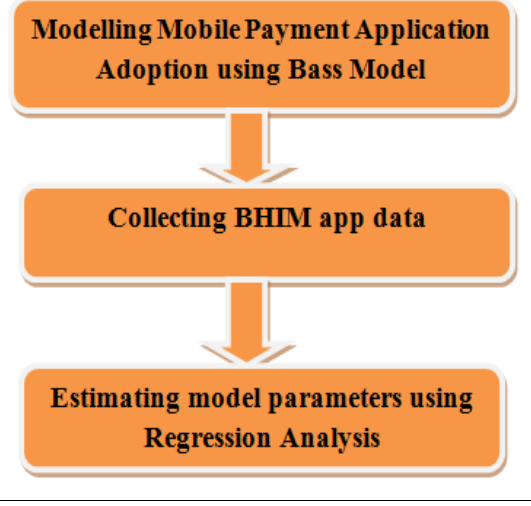
Figure 1. Research